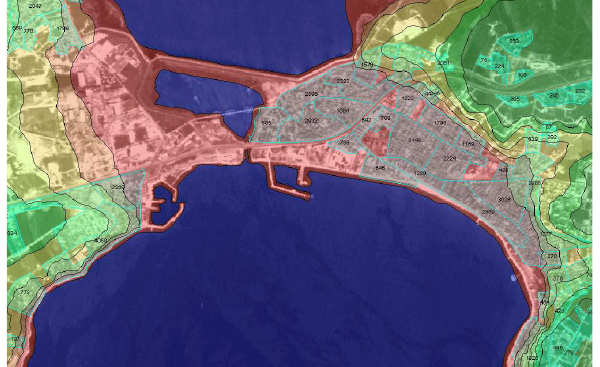
Figure 3. Tsunami Run-up simulation an area near Istanbul (Kemper et al., 2005) calculated by Land-use data (Kasanko et al., 2000) and DTM by basic equations (Heitner,